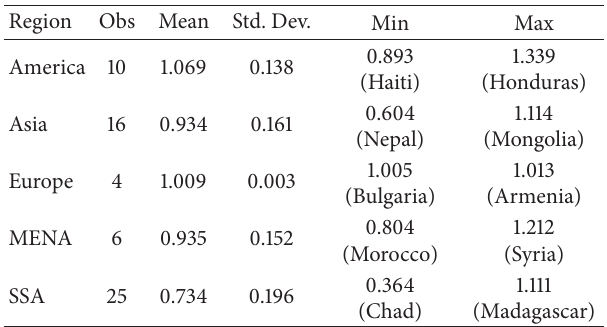
Table 1: Gender parity in secondary education by region,